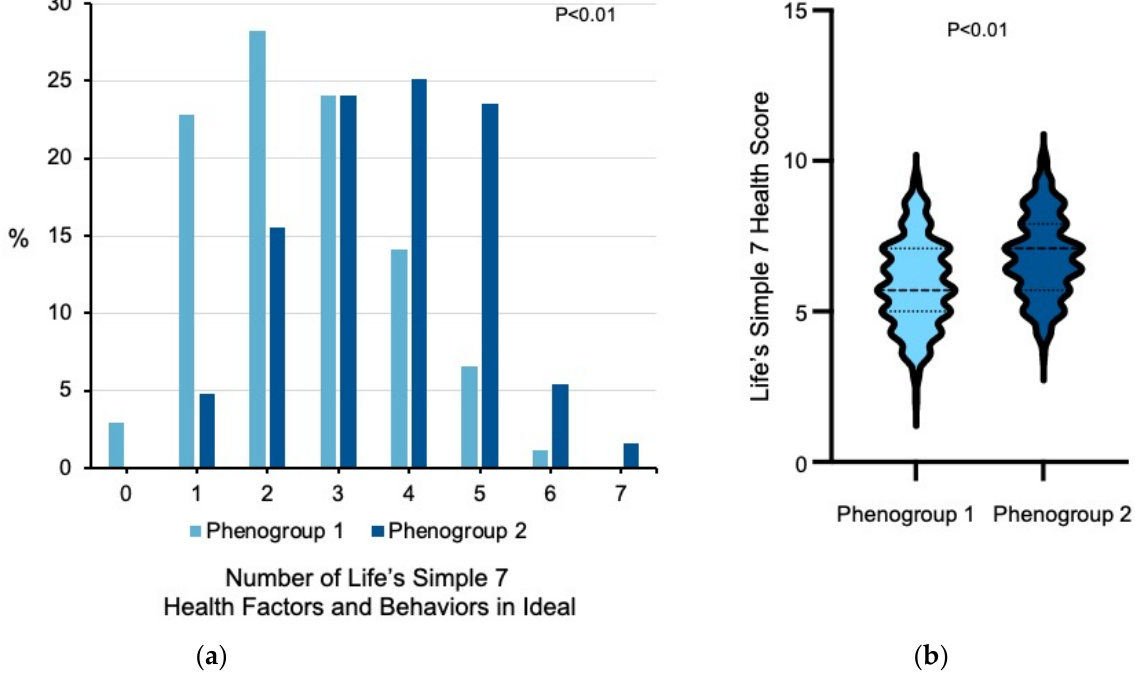
Figure 3. Former smoker phenogroups and measures of ideal cardiovascular health. ( a ) Life’s Simple 7 health factors and health behaviors are scored according to predefined criteria as poor, intermediate, or ideal. For each former smoker in phenogroup 1 ( n = 241) and phenogroup 2 ( n = 187), the number of health factors or behaviors that were scored in the ideal category is shown. Data was analyzed using the Wilcoxon rank sum test. ( b ) The distribution of Life’s Simple 7 Health Scores for former smokers in each of the phenogroups is presented as violin plots. The median and quartiles are denoted by dashed lines. Data was analyzed using the Wilcoxon rank sum test.